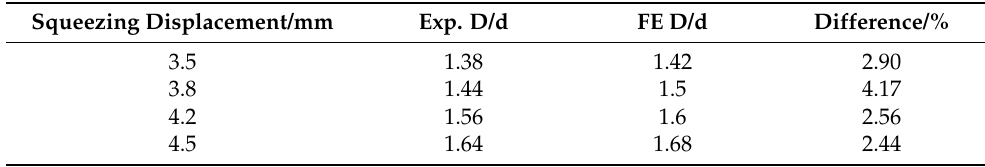
Table 3. The Driven Head Deformation of